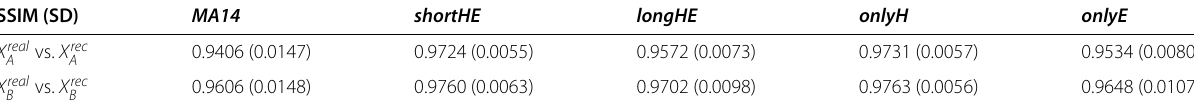
Table 4 SSIM scores (SD = standard deviation) for all experiments between real and rec images for A and B SSIM (SD) MA14 shortHE longHE onlyH onlyE